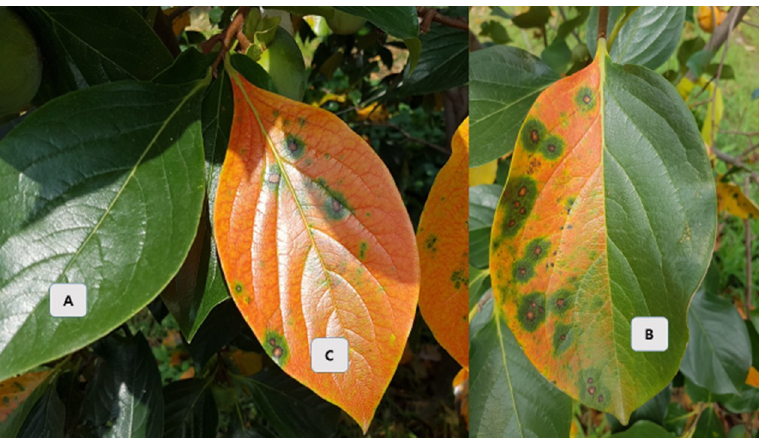
Fig 1. Different types of leaves. A. asymptomatic leaf at two collection time point (H1, H2). B. symptomatic leaf (D). C. Diseased containing 1/2 healthy part (1/2 H, 1/2 D).